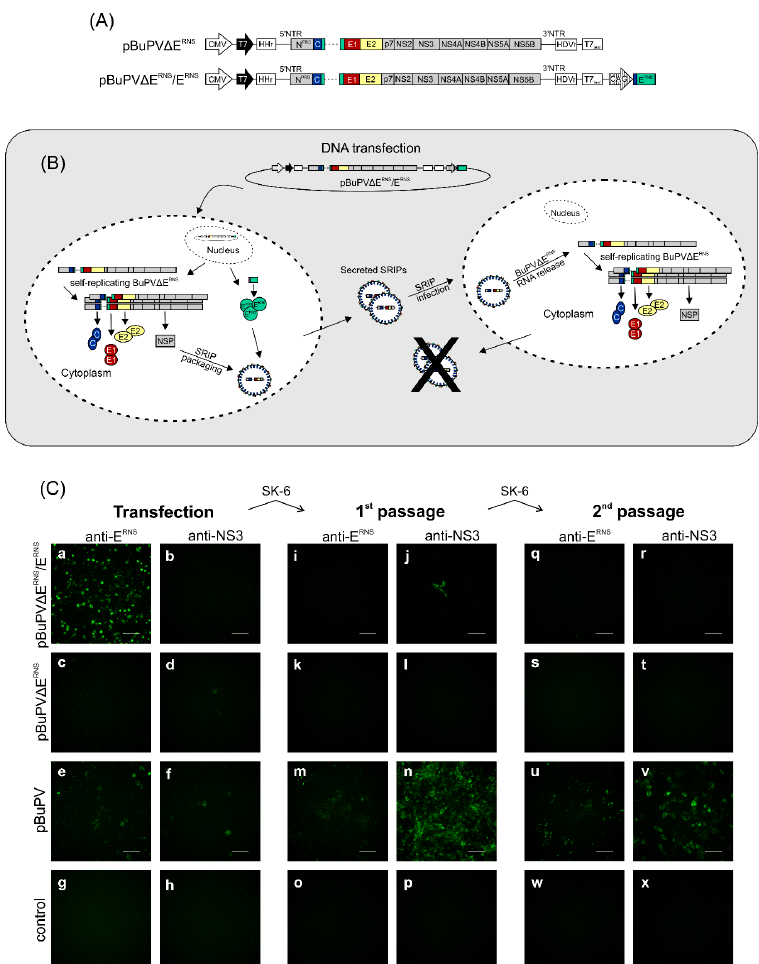
Figure 3. Schematic representation of the plasmids pBuPV ∆ E RNS and pBuPV ∆ E RNS /E RNS and production of rBuPV and BuPV-SRIPs. ( A ) The replicon construct pBuPV ∆ E RNS was generated on the basis of the CMV immediate early promoter containing plasmid pBuPV by partial deletion of the E RNS encoding genomic region (aa 328–483); the split genome plasmid pBuPV ∆ E RNS /E RNS contains two eukaryotic promoters. The CMV promoter (open arrow) controls transcription of BuPV replicon RNA, BuPV ∆ E RNS , which expresses the non-structural protein genes and the structural protein genes C, E1, and E2. The CAG promoter (shaded arrow) downstream T7 term directs the expression of BuPV-E RNS . Indicated is also the T7 promoter (black arrow), and the hammerhead ribozyme (HHr), and the 3 ′ hepatitis delta virus ribozyme (HDVr), which are important for the generation of the correct termini of the transcribed replicon RNAs. ( B ) Generation and operation mode of BuPV single round infectious particles (SRIPs) [47]. When cDNA of pBuPV ∆ E RNS /E RNS is transfected into susceptible cells, RNA-transcription starts in the nucleus under the control of the CMV promoter. The structural proteins C, E1, E2, and the non-structural proteins (NSP) are then expressed in the cytoplasm, while E RNS is expressed by the CAG promoter. The self-replicating, truncated RNAs can be packaged in SRIPs by the four essential structural proteins. The secreted SRIPs are able to infect new cells. The released RNA replicates autonomously in the cytoplasm and allows the expression of the structural proteins C, E1, and E2 but not of E RNS . Therefore, no further SRIPs can be produced and spread again (self-restriction). ( C ) IF analysis of BSR-T7 / 5 cells transfected with pBuPV ∆ E RNS , pBuPV ∆ E RNS / E RNS or pBuPV (a–f) or SK-6 cells infected with supernatants of DNA-transfected cells (1st passage, i–n) or infected with supernatants collected from cells after the first infection (2nd passage, q–v). IF staining using anti-NS3 or anti-E RNS monoclonal antibodies was performed at 72 h p.t. and 72 h p.i., respectively. Non-transfected or uninfected cells were used as control (g–h, o–p, and w–x). Scale bars indicate 100 µ